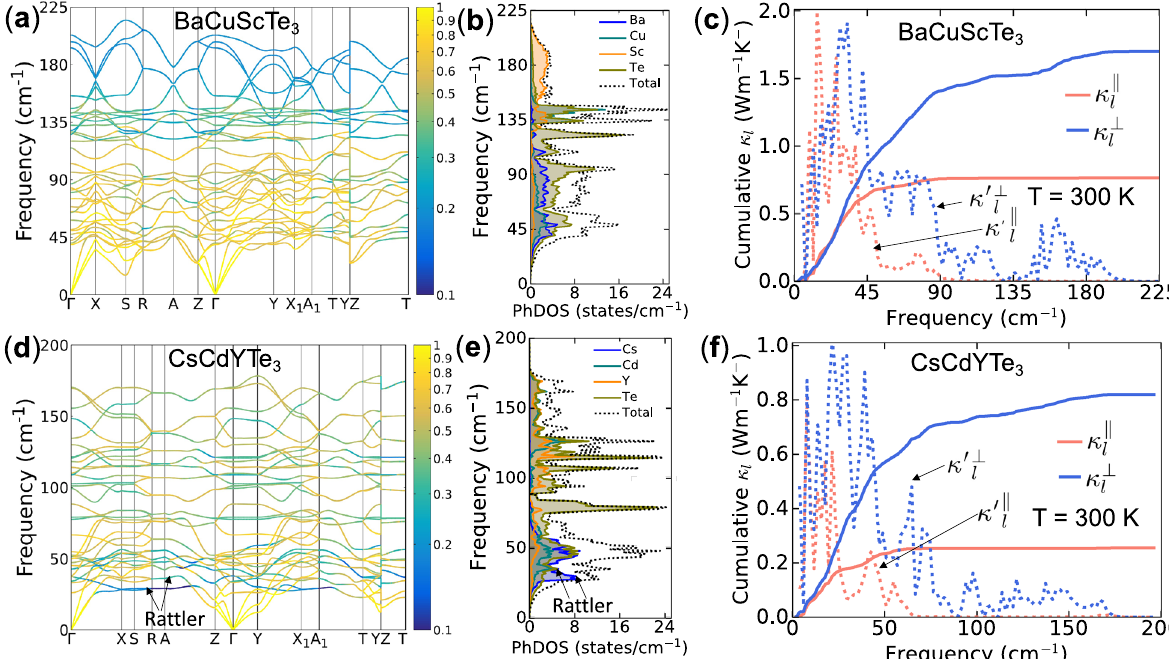
Fig. 6 Harmonic and anharmonic lattice dynamical properties of the AMM ′ Q 3 compounds. Harmonic phonon dispersions, atom-resolved phonon density of states, anharmaonic frequency-cumulative κ l , and their derivatives with respect to the frequency for BaCuScTe 3 ( a – c ) and CsCdYTe 3 ( d – f ). The phonon dispersions are color coded with the participation ratios of the phonon modes (indicated in the color bar). κ ? (solid blue line) and κ k (solid red line) are perpendicular and parallel to the stacking directions in the crystal structure of the AMM ′ Q 3 l ? (dotted blue line) and κ 0 k (dotted red line) are the fi rst-order derivatives of κ ? compound, respectively. κ 0 l l the frequency, which are in arbitrary units in the fi